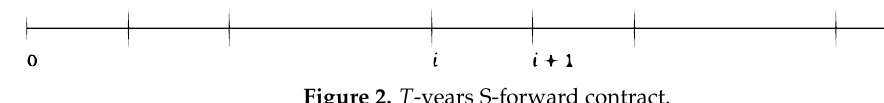
Figure 2. T -years S-forward